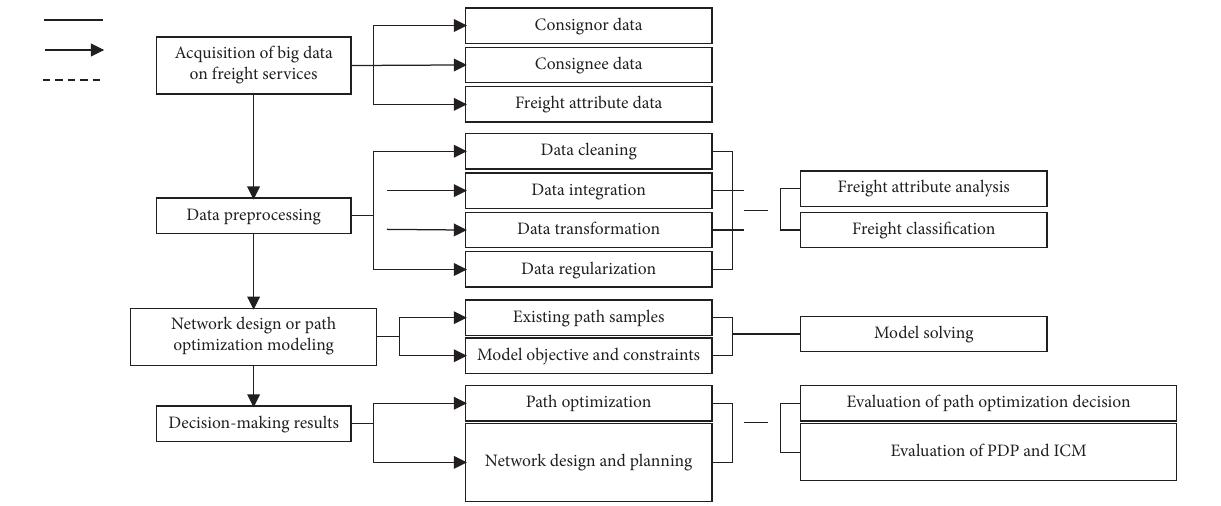
Figure 4: Architecture of the multimodal freight transport platform based on data